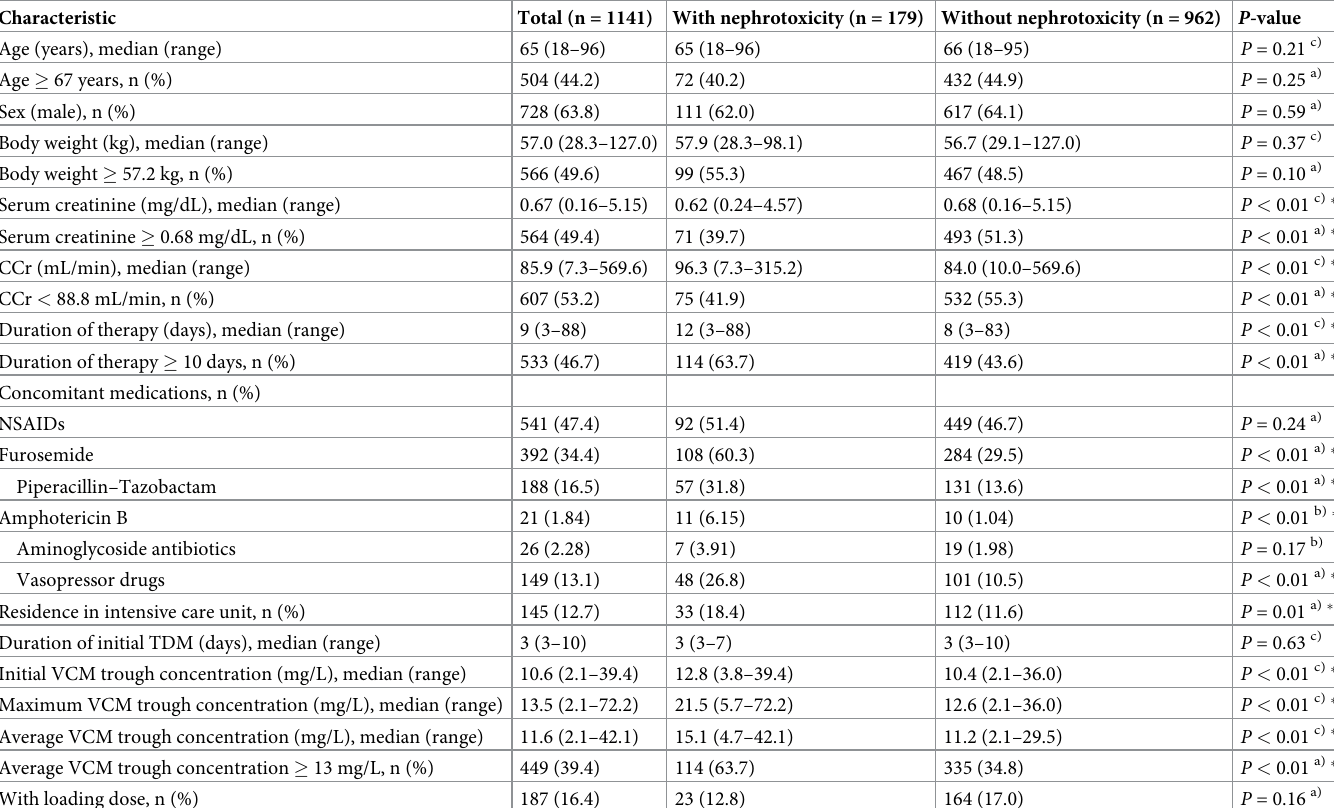
Table 1. Comparison of the characteristics of patients with and without nephrotoxicity.